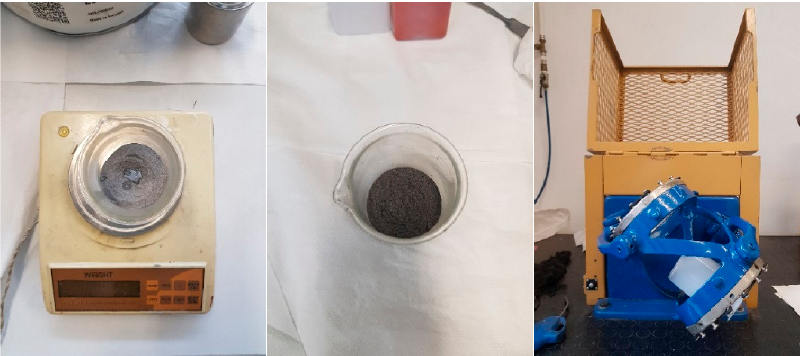
Figure 3. Different steps of the mixing process, for instance, the epoxy coating procedure.